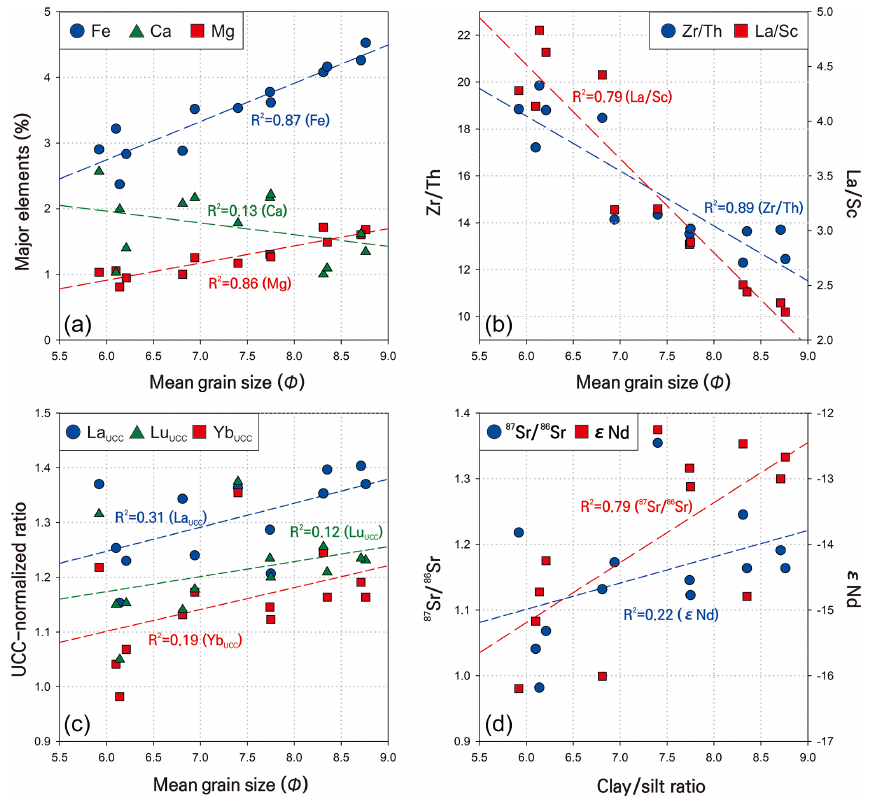
Figure 5. Correlation plots of grain size or clay/silt ratio with (a) major elements, (b) Zr / Th and La / Sc, (c) Upper Continental Crust (UCC)-normalized REEs (Taylor and McLennan, 1985), and (d) 87 Sr / 86 Sr and ε Nd for core